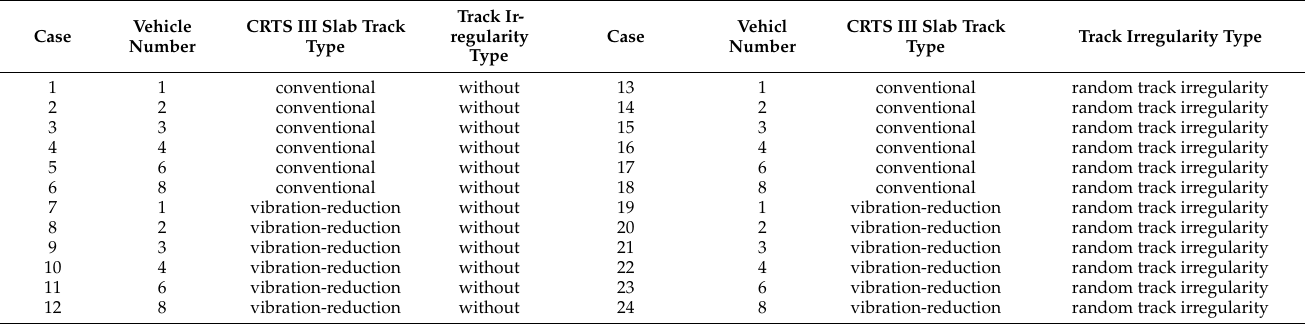
Table 4. Calculation parameters for load Cases